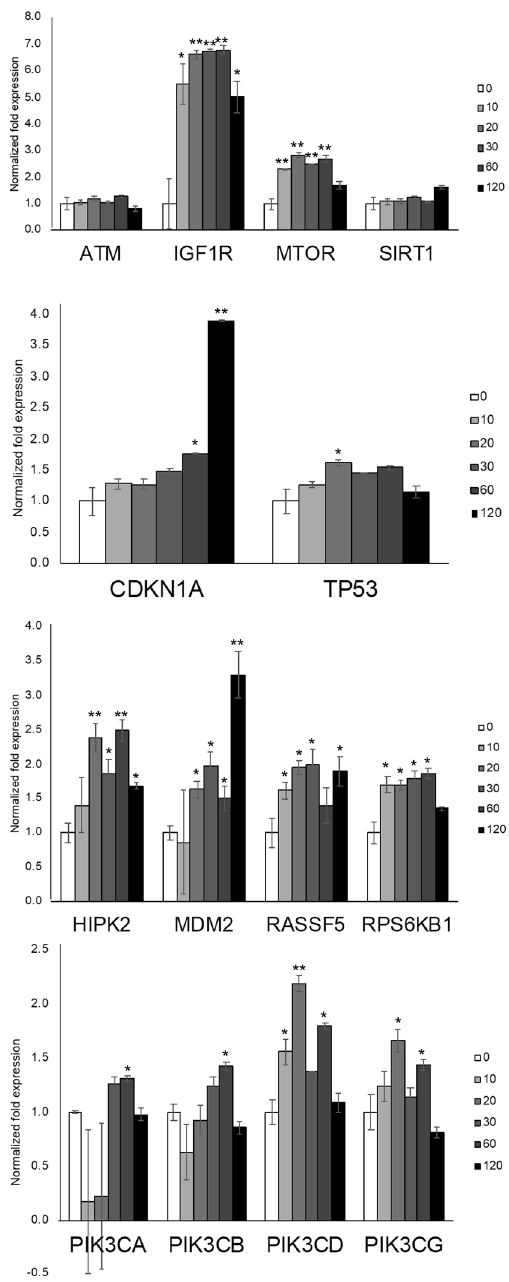
Figure 2. Gene expression changes in irradiated HLMVEC. HLMVEC were grown to 70% confluence and exposed to 10 Gy X-ray irradiation. RNA was obtained at the indicated time points. mRNA levels in irradiated HLMVEC were assessed by RT-qPCR at indicated time points post-irradiation. Graph represents means, ± SEM from n = 3 independent experiments. p < 0.05 is indicated by *, p < 0.01 is indicated by